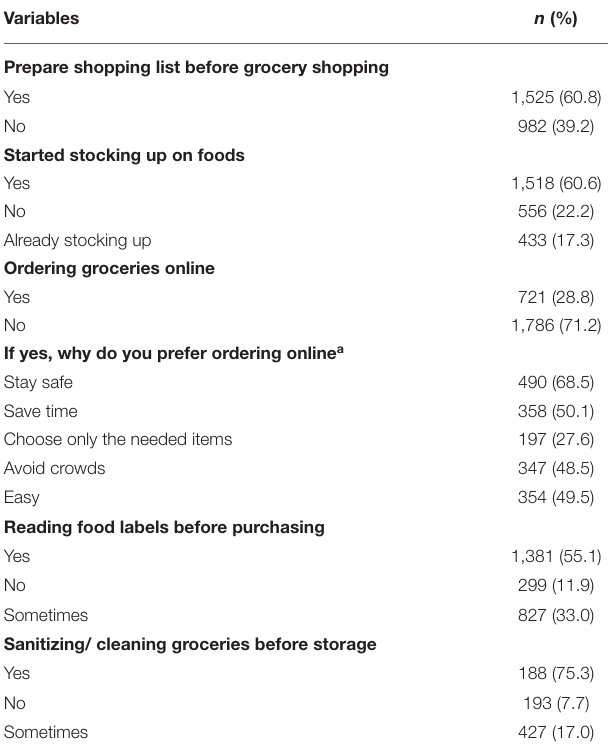
TABLE 5 | Shopping practices during COVID-19 pandemic ( n =